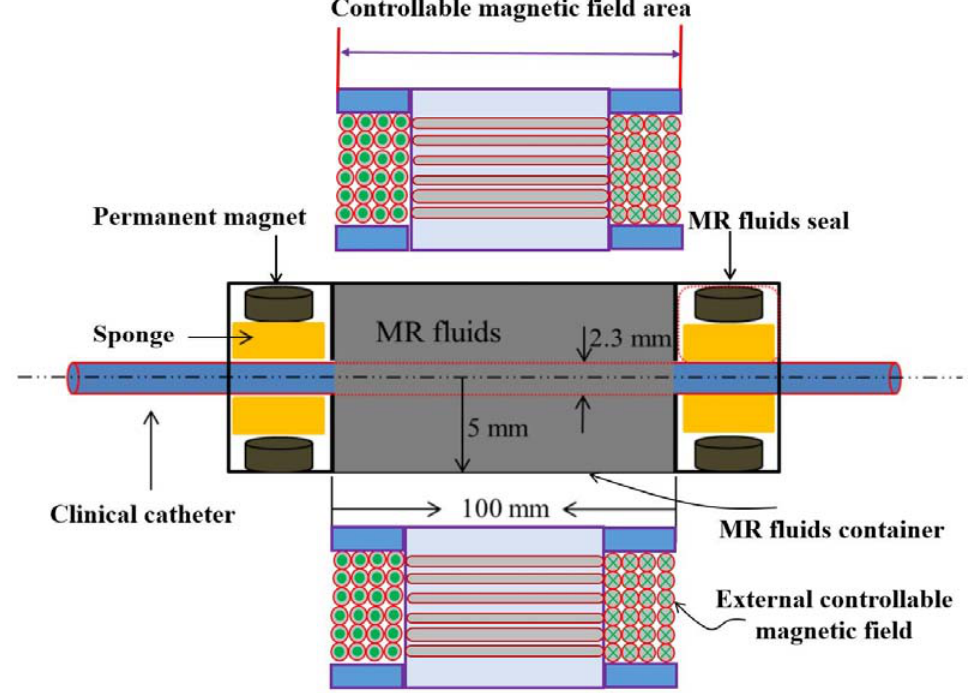
Figure 8. Schematic diagram of MR fluids seal.